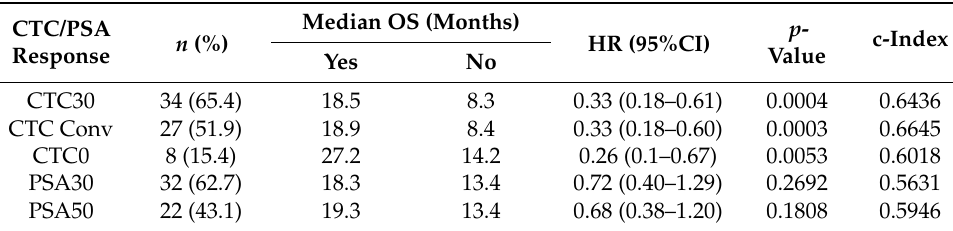
Abbreviations: OS, overall survival; CTC, circulating tumor cells; PSA, prostate specific antigen. Yes and No: Patients